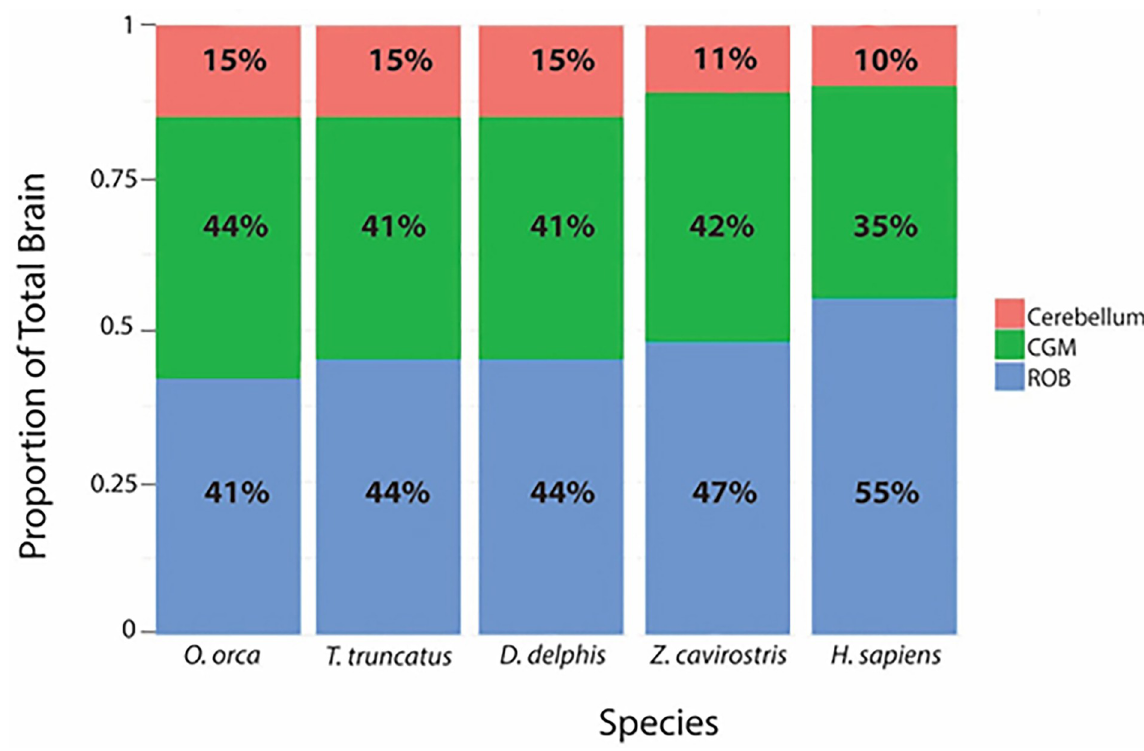
Fig 5. Comparison of neonates and adults for the only two cetacean species where such data is available. Brain and body size, brain cell density, and cortical surface area comparisons between neonates and adults representing two dolphin species, Tt (A) and Oo (B). All data are from individual animals. Brain and body mass data as well as neuron and glial cell densities for the neonate Tt were published previously [40].